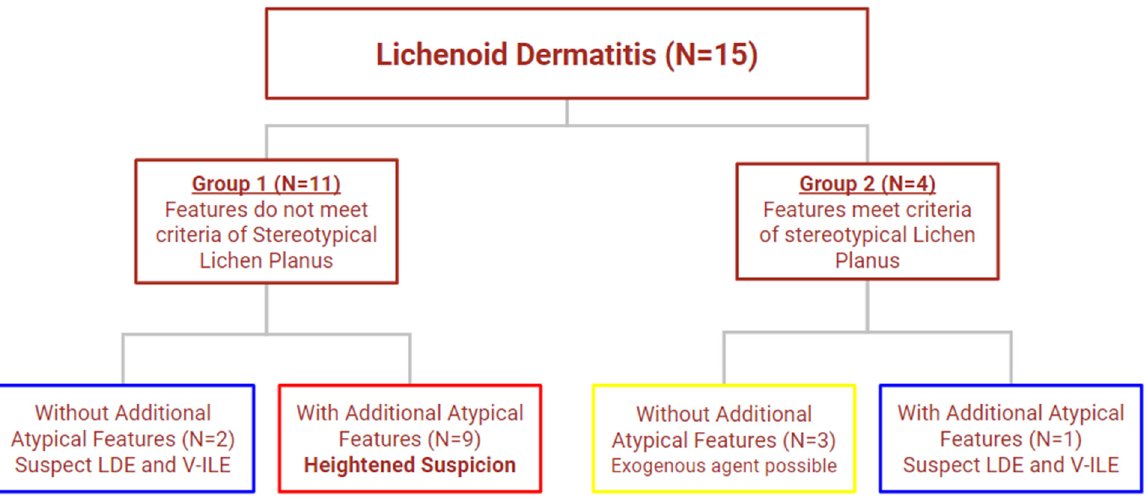
Figure 19. Fifteen cases of lichenoid dermatitis were classified into four groups based on whether they met criteria of stereotypical lichen planus and whether they showed additional atypical features. N, number of cases; LDE, lichenoid drug eruption; V-ILE, vaccine-induced lichenoid eruption. Key for colored boxes: Group 1a, blue; 1b, red; 2a, yellow; 2b, blue.